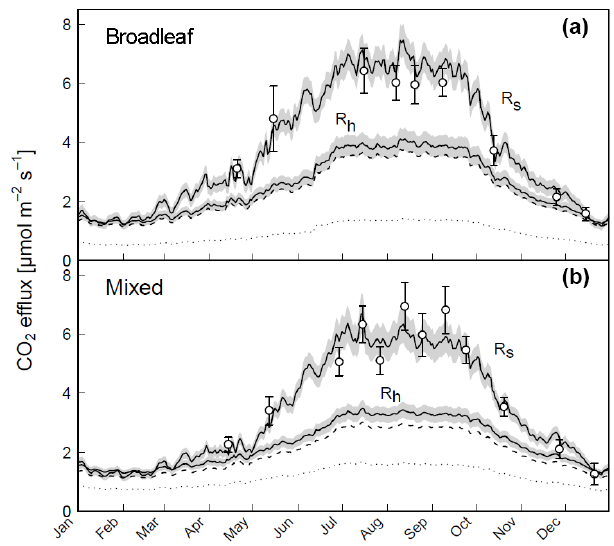
Figure 4. Seasonal course of modelled soil CO 2 efflux ( R s ) and heterotrophic soil respiration rates ( R h ) at a broadleaf and mixed forest in Bhutan Himalayas in 2015. Open circles are measured R s rates. Error bars and shaded areas represent standard error of the daily mean. Dashed and dotted lines indicate the CO 2 contributions of litter and mineral soil layers to R h . The area between the full line (total R h ) and the dashed line represents the contribution from litter, the area between dashed and dotted line represents the contri- bution of the topsoil (0–10cm), and the area below the dotted line represents the contribution from the 10–30cm mineral soil